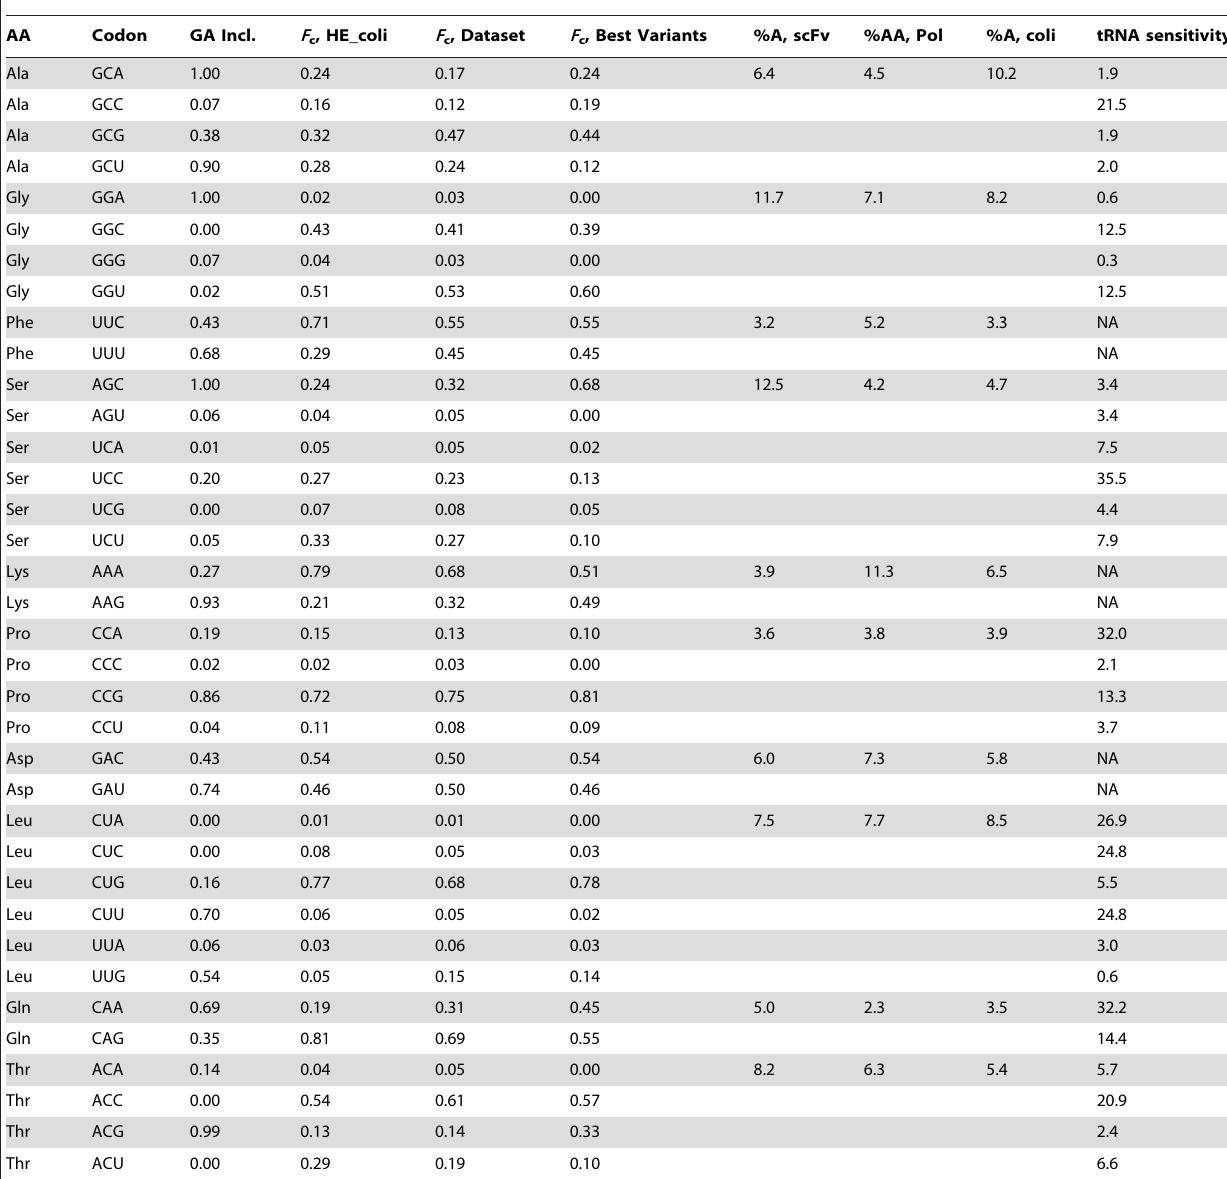
Table 2. Codon biases that predict expression in PLS models of the combined